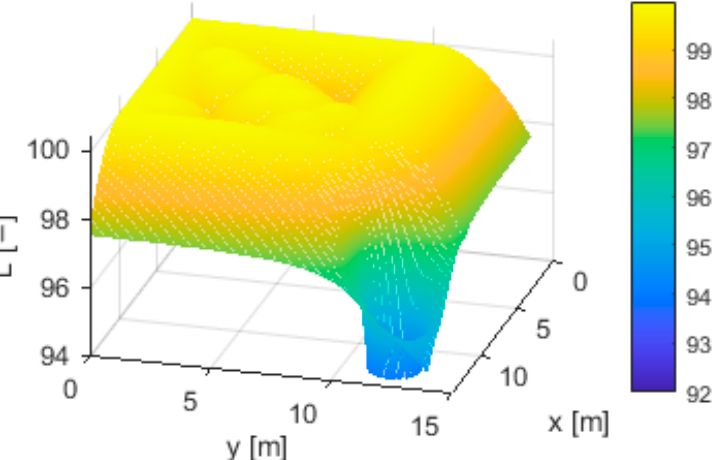
Figure 16. Enlargement of the region of interest of the results of the Lyapunov function 𝐿 over the whole navigation area for Agent J.